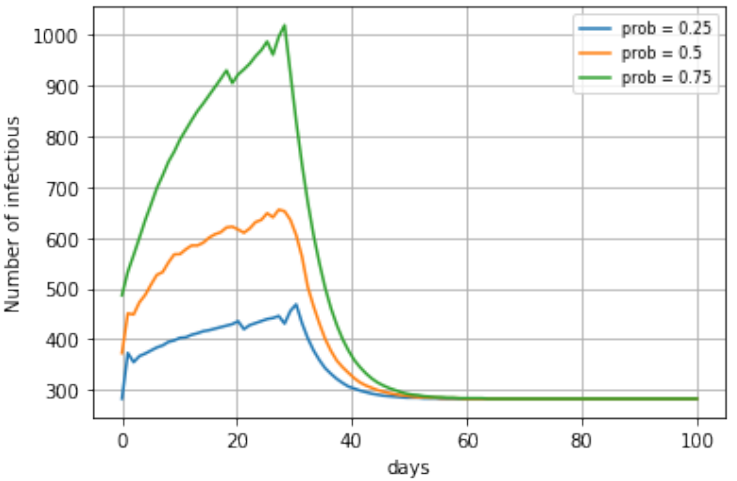
Figure 12. Three hypothetical infection rate patterns of the number of new cases during the observa- tion